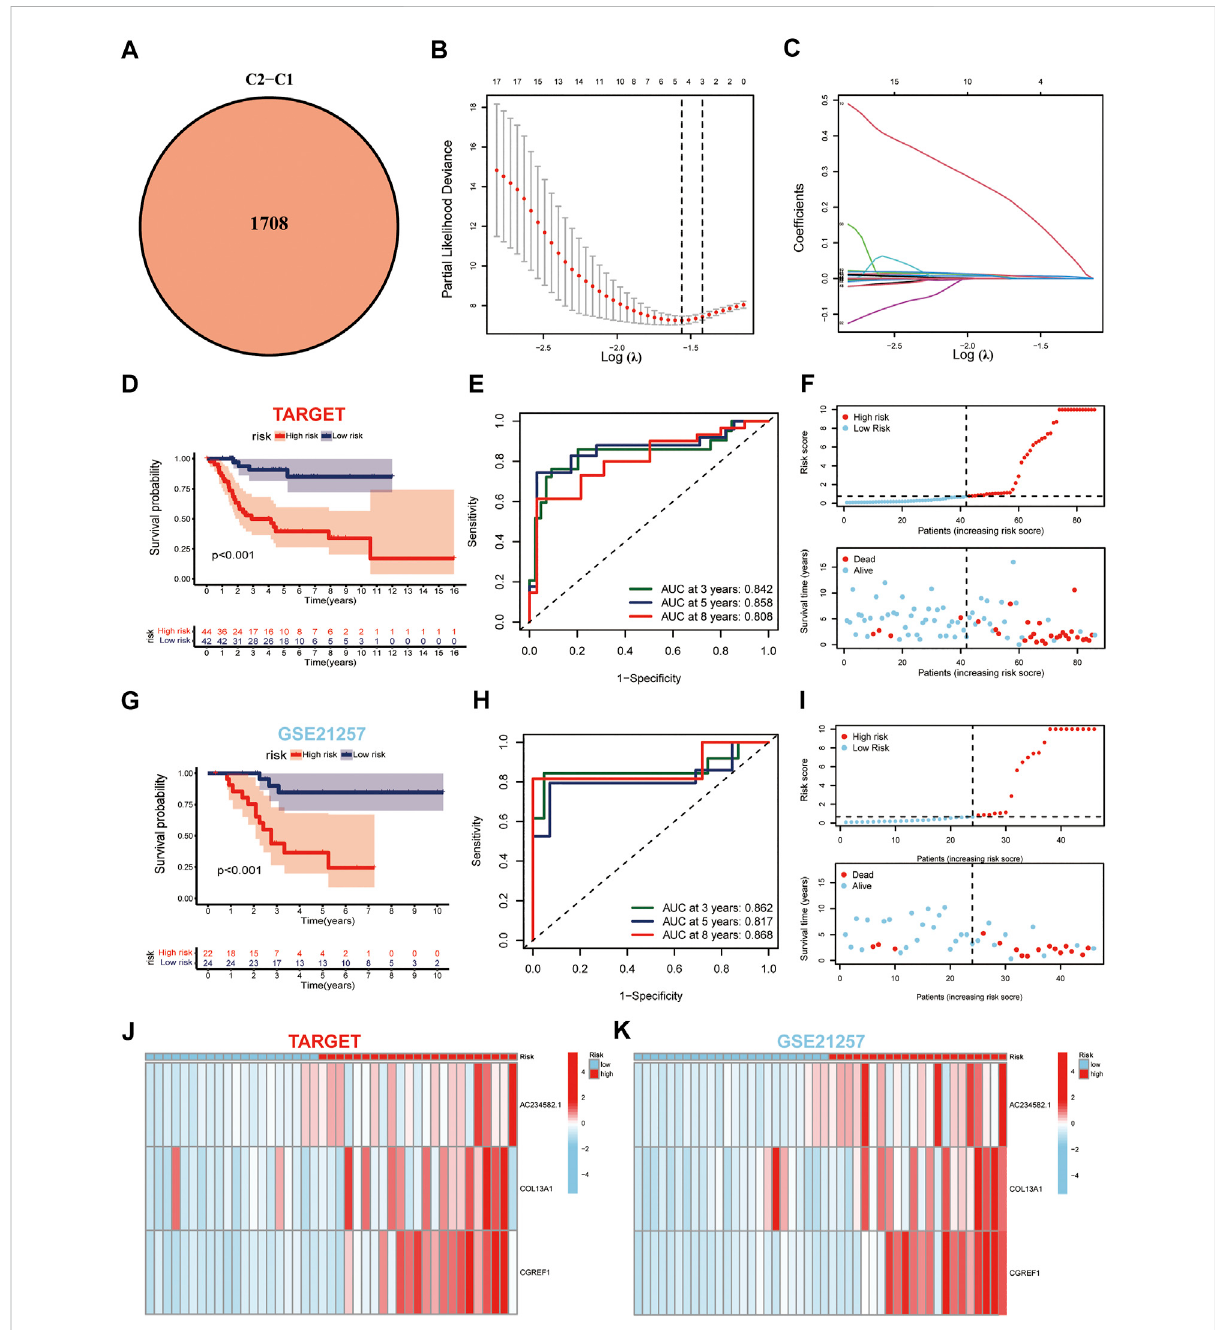
FIGURE 4 Generationand validation of theprognosticmodel. (A) Venn diagram of theDEGs via pairwise comparison among twosubgroups. (B,C) LASSO regressionanalysis used to construct theprognostic model. (D) Survival analysis in theTARGET-OScohort. (E) ROC curves for thepredictivesurvival in TARGET-OS cohort. (F) Ranked dot and scatter plots showing the risk score distribution and patient survival status in TARGET-OS cohort. (G – I) Validation of prediction results from GSE21257 dataset against TARGET database. (J,K) Expression patterns of three selected prognostic genes in high-and low-risk